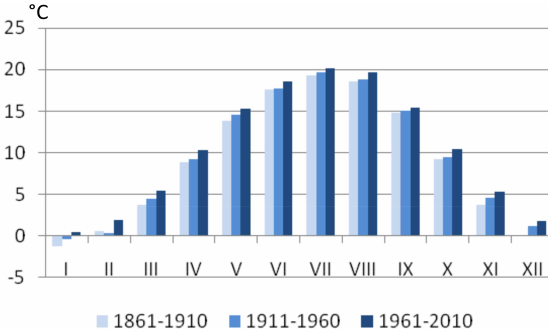
Figure 2. Development of average temperatures (in °C) based on records from the Klementinum meteoro- logical station in Prague since